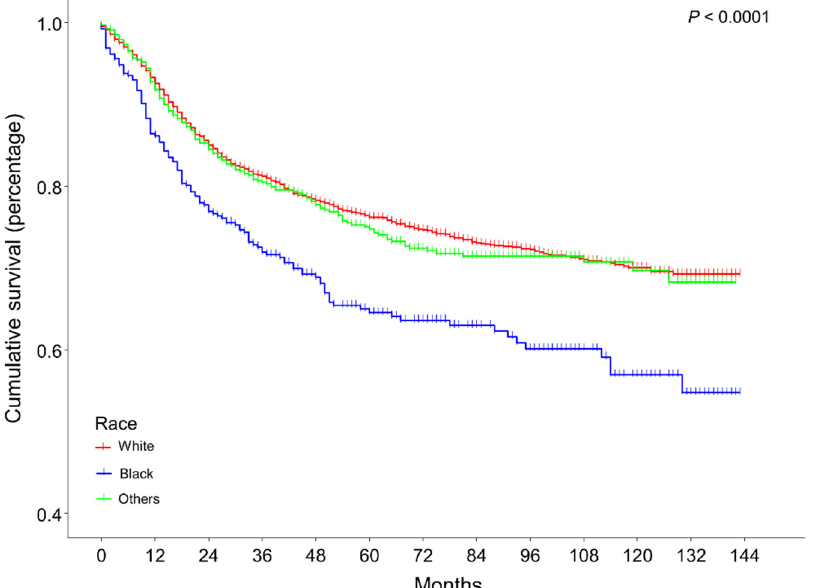
Figure 1. K m plotter of overall survival for patients with cervical cancer in different races. The overall survival for cervical cancer patients of different races (log-rank p value < 0.0001). The survival was significantly lower in the black race than in the white (BH-adjusted p value < 0.001) and other races (BH-adjusted p value < 0.001). However, no statistical difference was observed between the white race and other races (BH-adjusted p value = 0.62).